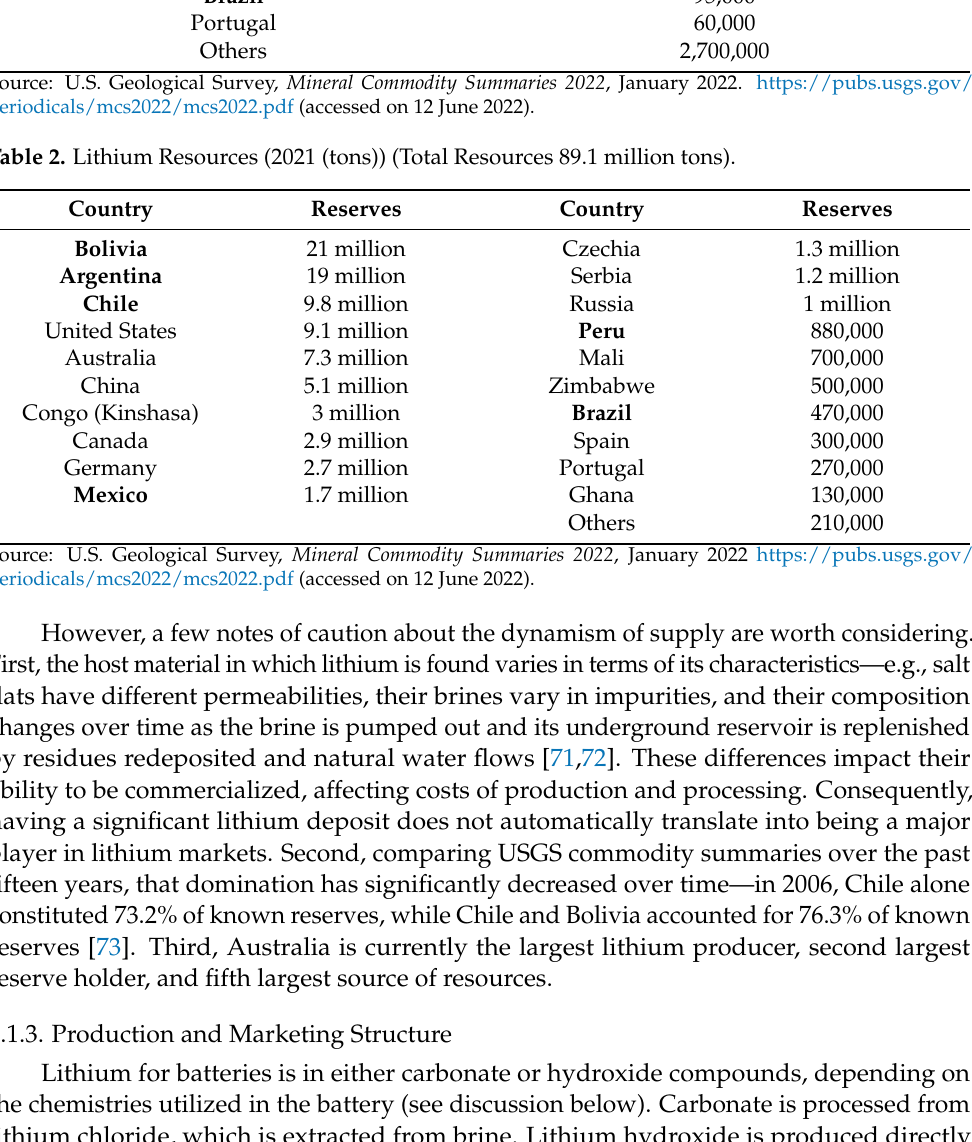
Table 1. Lithium Reserves (2021 (22 million tons, rounded)). Chile